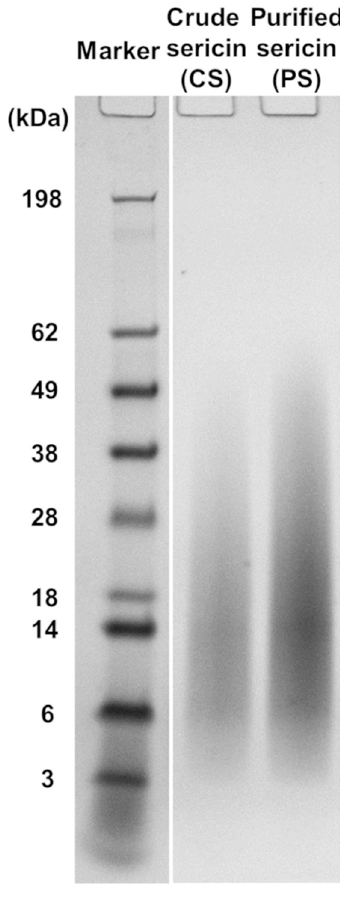
Figure 1. Molecular mass distribution in the sericin regenerated from B. mori cocoons, as determined by SDS-PAGE. The electrophoretic patterns of non-dialyzed (crude) and dialyzed (purified) products are shown.